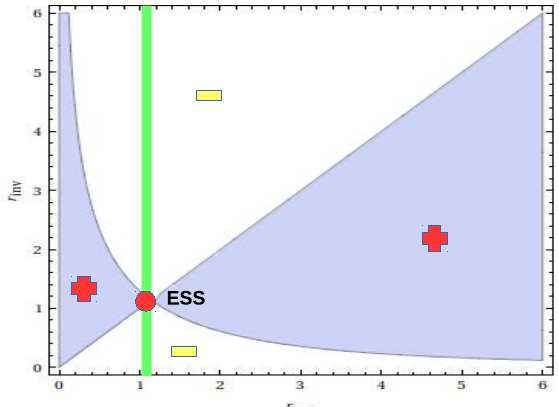
Fig. 6. Pairwise invasibility